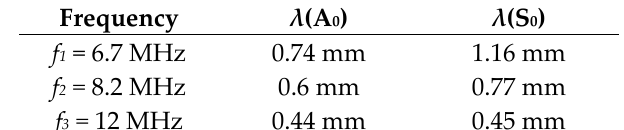
Table 1. Calculated wavelengths of the lower acoustic modes generated in the substrate.